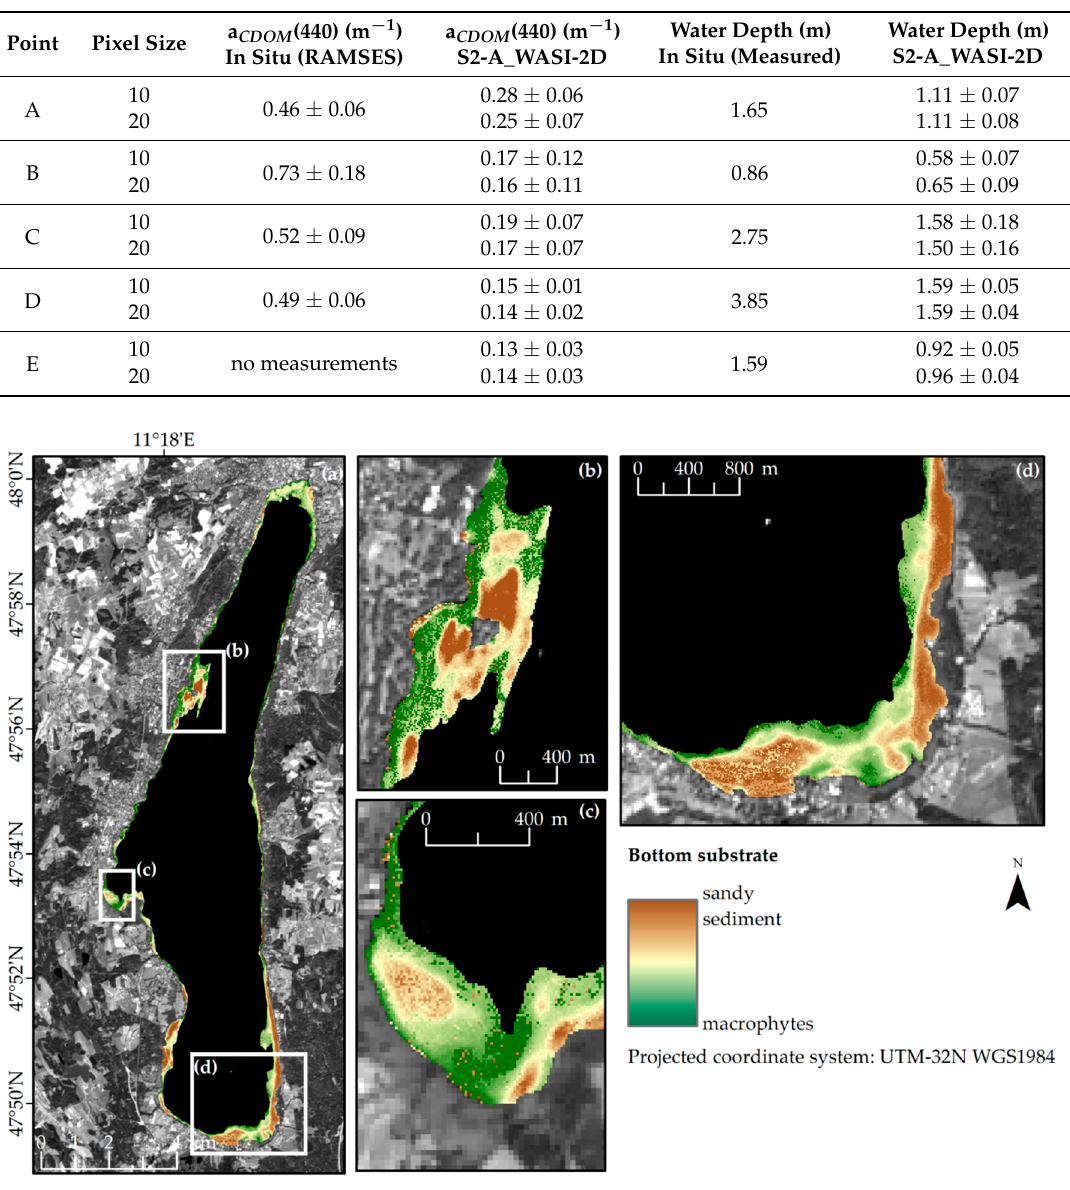
Table 3. Comparison between in situ measured and S2-A (WASI-2D) results in optically shallow water. Term in parentheses indicates in situ data source. Mean and standard deviation of 5 × 5 respectively 3 × 3 pixel environment were calculated for 10 m respectively 20 m pixel size and reflect spatial variability. Errors for in situ data (RAMSES) are derived from inversion and reflect variability during a measurement series.